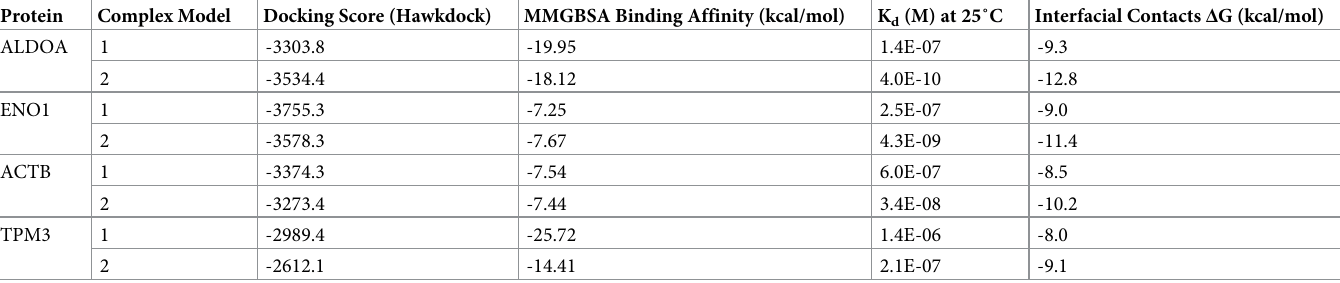
Table 2. Protein-protein molecular docking scores obtained for the best two conformations of MT-3 and its binding partners. Protein Complex